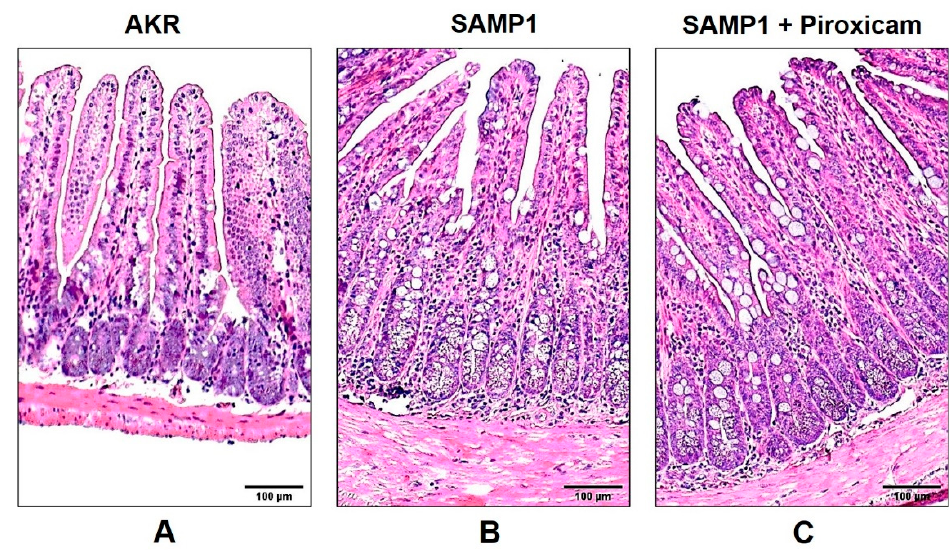
Figure 1. Illustrative photomicrographs of cross sections of the ileum of AKR and SAMP1 mice stained with hematoxylin and eosin (H&E). ( A ) The AKR mouse ileum depicts the typical long villi, short crypts and minimal intraepithelial immunocytes. ( B ) SAMP1 mouse intestine demonstrates crypt hypertrophy, villus blunting, and increased intraepithelial lymphocytes characteristic of inflammatory bowel disease (IBD). ( C ) In vivo treatment of SAMP1 mice with piroxicam, a COX pathway inhibitor, did not show any changes in the ileal structure in SAMP1 mice. Original magnification 10 × . Scale bar 100 µ m.